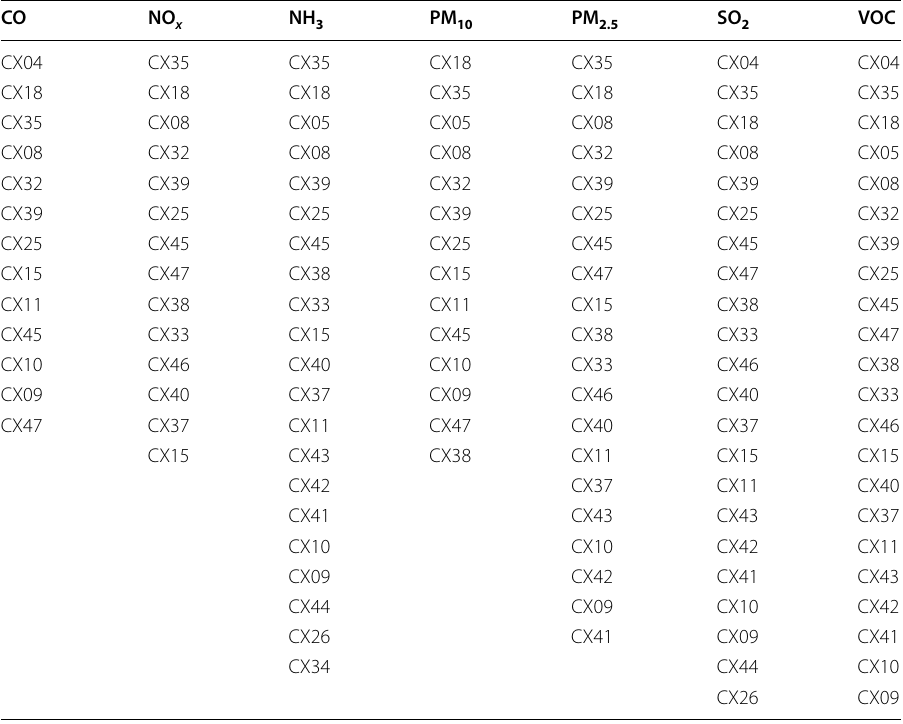
Table 7 Emission inventory decomposition in 2050: sectors for a dominant technology